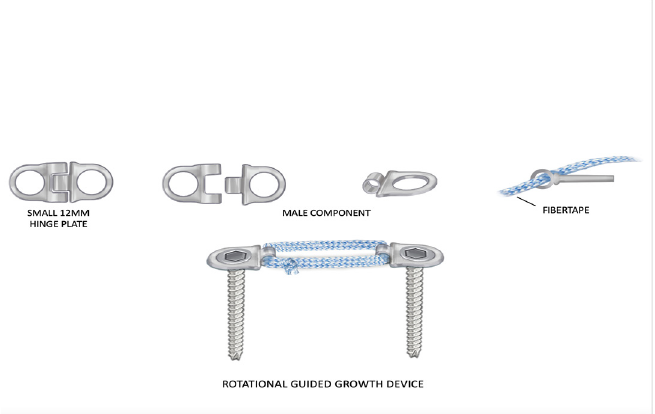
Figure 2. Illustration of the components of the rotationally guided growth implant used. Two of the same halves of the hinge plate were used. They were tethered together with fibertape. They were fixed to the bone with screws. Illustrations copyrighted to the Paley Foundation; reprinted with permission.